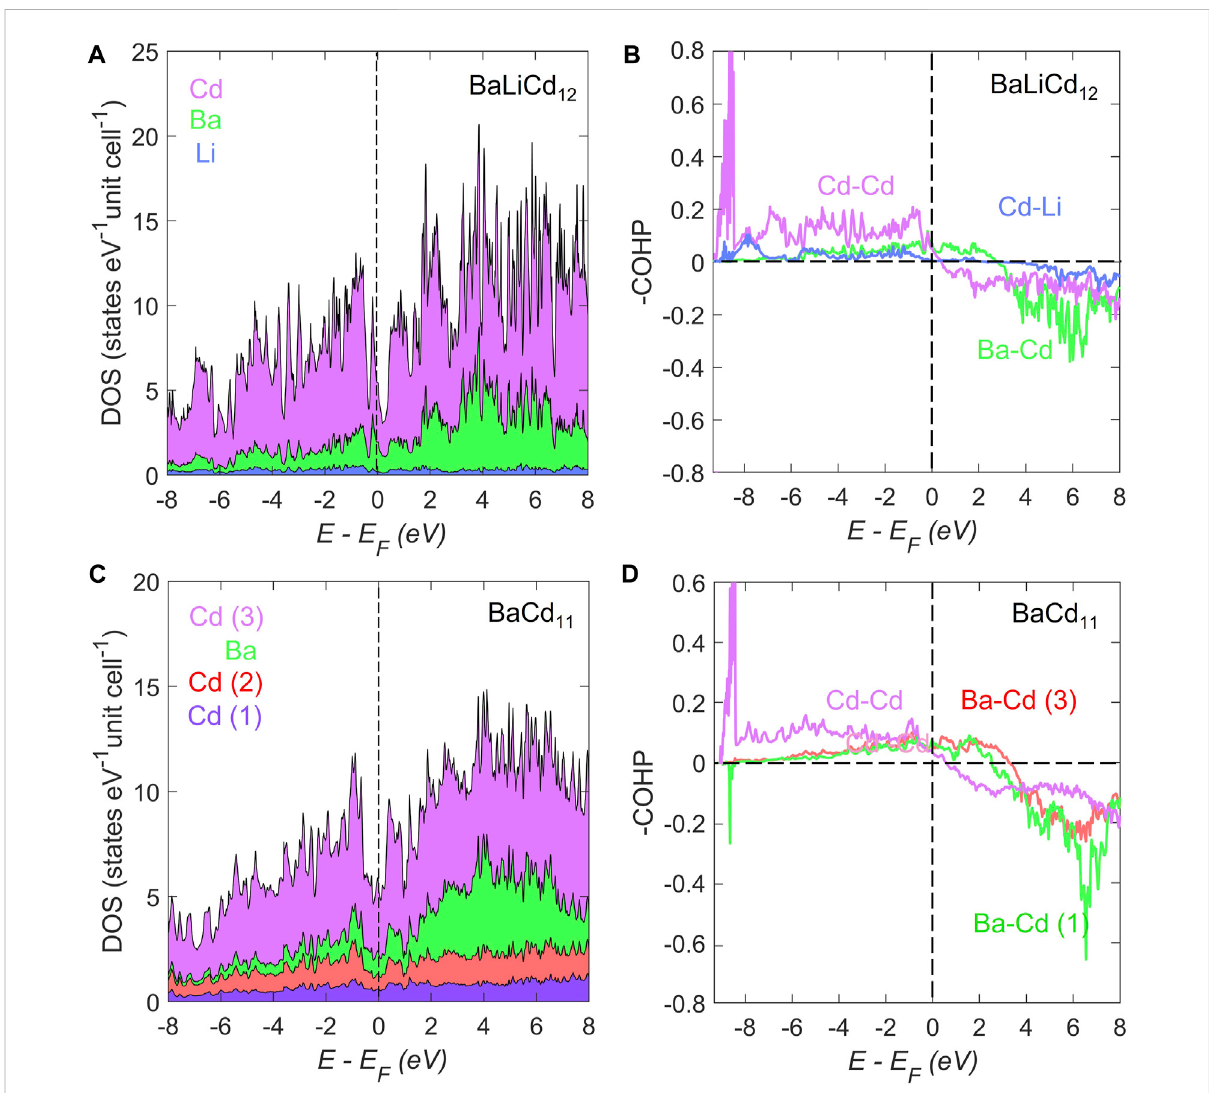
FIGURE 2 The atom-projected electronic density of states (DOS) for (A) BaLiCd 12 and (C) BaCd 11 . The DOS of both compounds exhibit characteristics of metallic bonding. A relatively larger dip can be observed in the BaLiCd 12 compound compared to that of BaCd 11 . The crystal orbital Hamilton population curves (COHP) for the averaged selected interactions of (B) BaLiCd 12 and (D) BaCd 11 . For BaLiCd 12 , the Ba – Cd interactions are underoptimized at the Fermi level, while the Cd – Li and Cd – Cd interactions are almost optimized at the Fermi level. In contrast, for BaCd 11 , all interactions are under-optimized at the Fermi